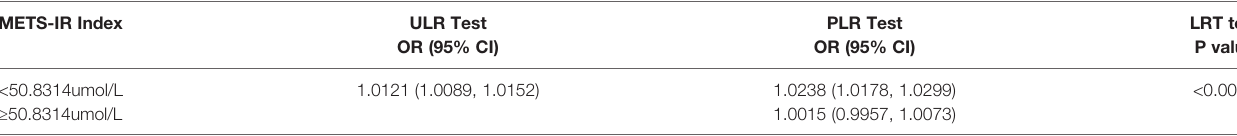
TABLE 3 | Two-piecewise linear regression and logarithmic likelihood ratio test explained the threshold effect analysis of METS-IR index on kidney